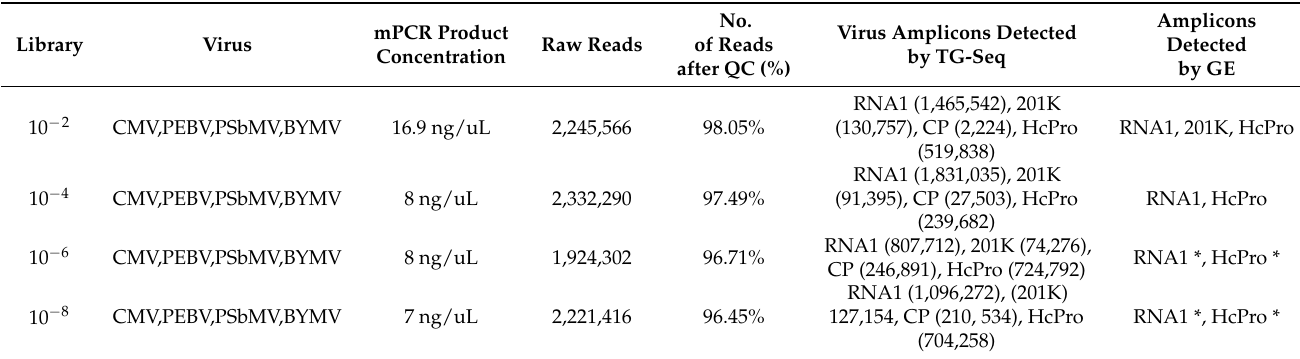
Table 4. A comparison of the sensitivity of targeted genome sequencing (TG-Seq) and gel electrophoresis (GE) to detect BYMV, PSbMV, PEBV and CMV amplicons generated in a multiplex PCR (mPCR) reaction.